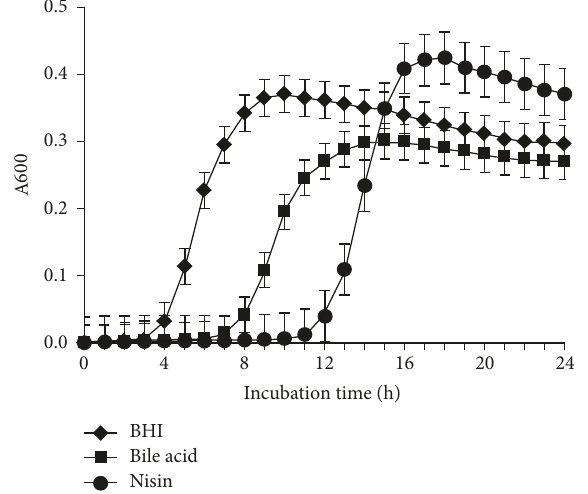
Figure 4: Effect of low concentrations of bile acids and nisin on C. perfringens SM101 spore